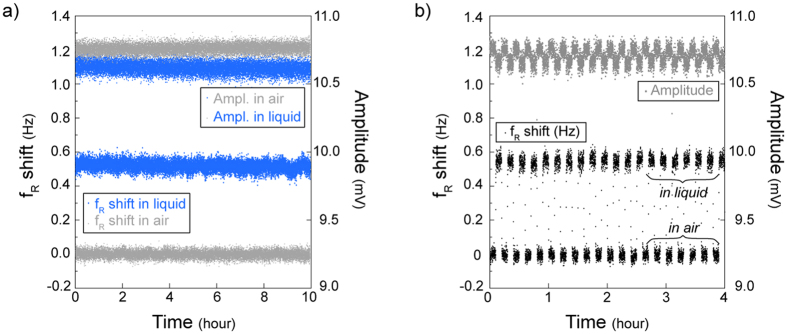
(a) Real-time measurements for more than 10 hours demonstrated the stability of the system. The measurements were displayed as fR shift between the air and liquid conditions for each experiment. The result shows an fR shift of 0.48 + 0.03 Hz and an Amax of 10.62 + 0.04 mV (mean + std. dev.) with respect to the in-air result (0.00 + 0.02 Hz, 10.76 + 0.03 mV). (b) Repeated insertion and removal cycles showed the same fR shift indicating the stability and repeatability of the insertion protocol. 6 minutes cycles of in-air and in-liquid measurements were performed for 4 h.